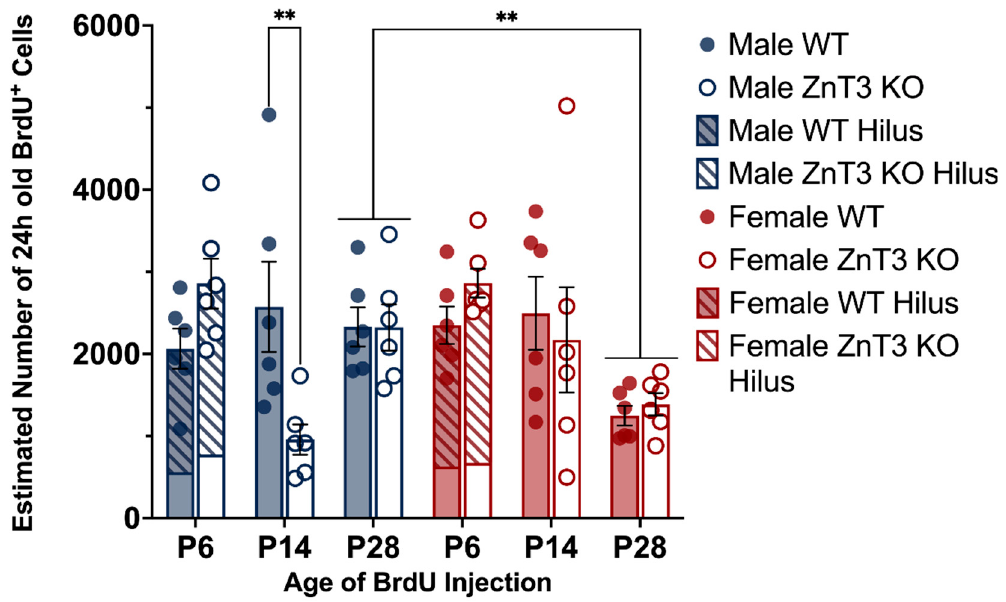
Figure 3. Proliferation of cells labelled at P6, P14, and P28, as measured by BrdU + cells, in male and female WT and ZnT3 KO mice. BrdU was administered to male and female WT and ZnT3 KO mice on P6, P14, or P28 to label dividing cells ( n = 6 per group). To assess cell proliferation, brains were collected approximately 24 h after the last injection, and BrdU + cells were counted in the hilus and SGZ/GCL for P6 brains (P6 bars represent the aggregate; diagonal stripes indicate counts from the hilus) and the SGZ and GCL for P14 and P28 brains. Male WT mice injected on P14 had significantly higher numbers of BrdU + cells compared to male ZnT3 KO mice. Male mice injected on P28, regardless of genotype, had significantly higher numbers of BrdU + cells compared to female mice. Error bars represent ± standard error of the mean. ** Indicates p < 0.010.